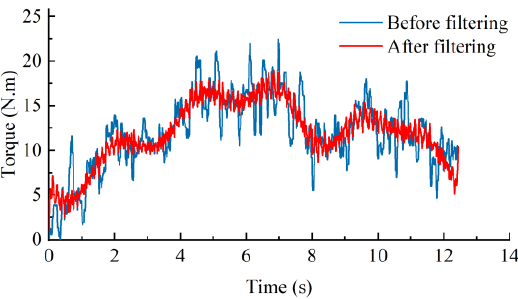
Figure 8. Time domain diagram before and after signal processing.